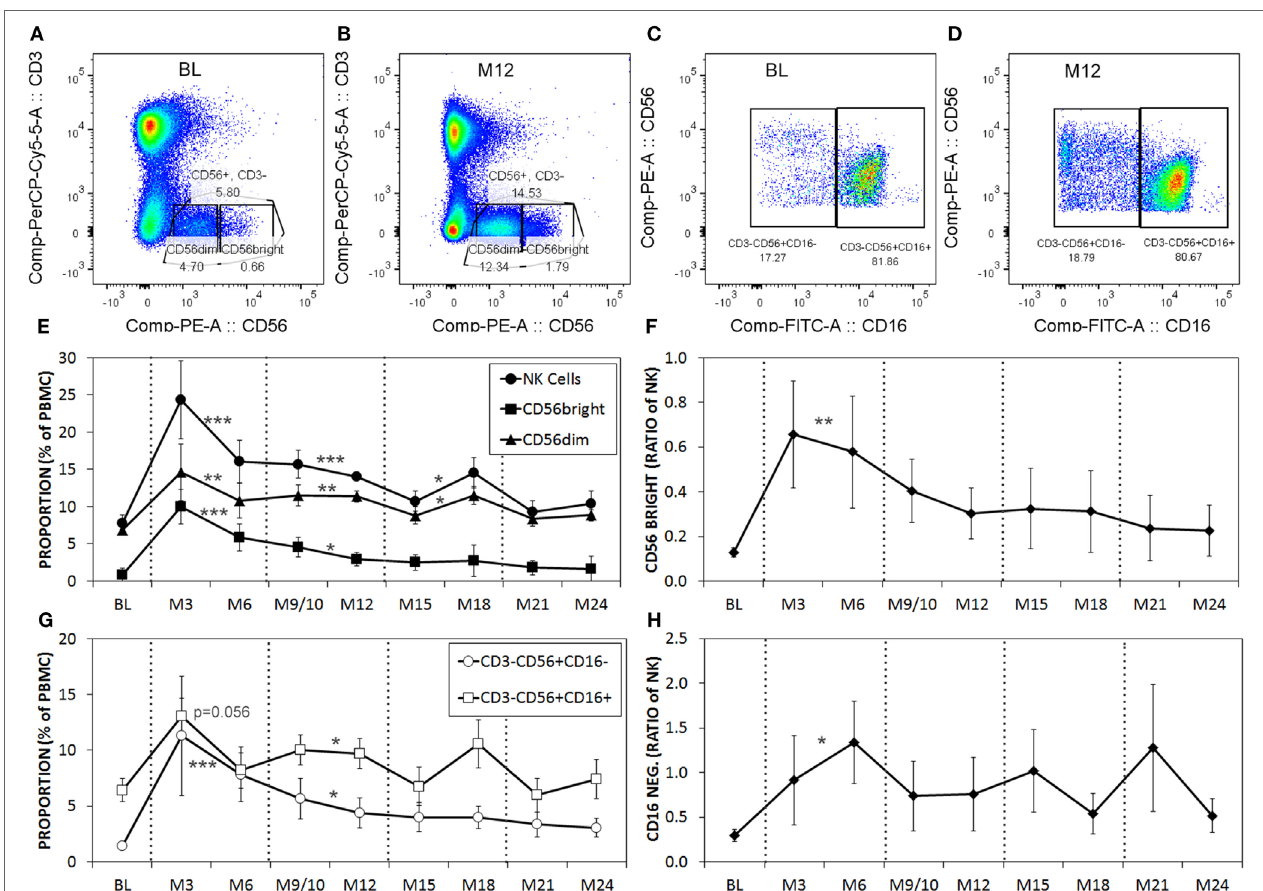
FigUre 2 | The proportions of CD56 dim and CD56 bright natural killer (NK) cells are higher post-aHSCT compared witho baseline (BL). Cryopreserved peripheral blood mononuclear cell (PBMC) from aHSCT-treated MS patients was analyzed by flow cytometry. Representative plots for BL (a,c) , and month 12 [M12; (B,D) ] stained for CD3 and CD56 (a,B) , gated on CD3 − CD56 + , then shown as CD56 with CD16 (c,D) . Example gates for CD56 bright and CD56 dim are shown. Additional time points include BL, and serial samples approximately every 3 months for up to 24 months post-aHSCT. The average proportions of total NK cells as well as CD56 dim and CD56 bright NK cell subsets expressed as a proportion of total PBMC (e) . The ratio of NK cells with the CD56 bright phenotype calculated as CD56 bright /CD56 dim NK cells (F) . The proportions of NK cells with CD16 + or CD16 − phenotype expressed as a proportion of total PBMC (g) . The ratio of gated NK cells with the CD16 − phenotype calculated as CD16 − /CD16 + (h) . N = 7 patients. For statistical analysis, the time points were grouped in M3–M6, M9–M12, M15–M18, and M21–M24, followed by univariate one-way ANOVA with pairwise comparisons with the BL